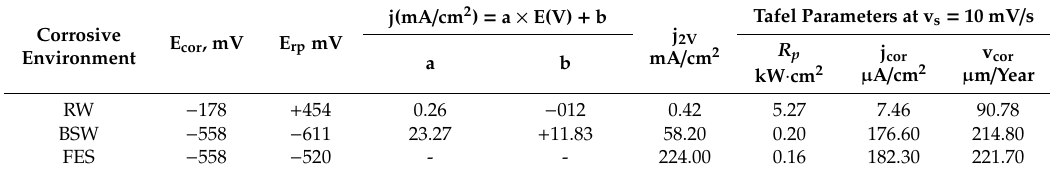
Table 11. Stimulated corrosion parameters for the III-Mn sample in the three corrosion environments. Corrosive Environment